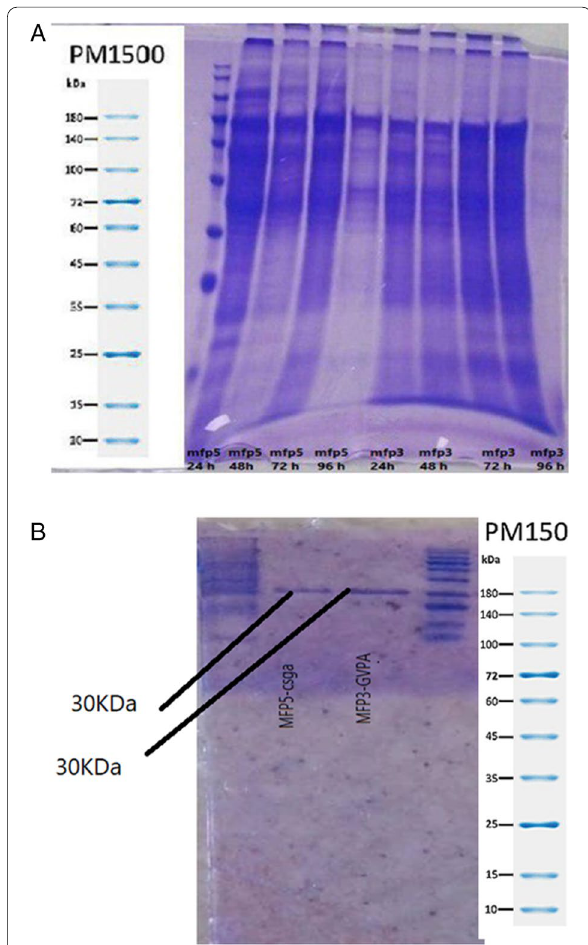
Fig. 2 SDS-PAGE analysis for purified fused recombinant proteins before ( A ) and after purification ( B )